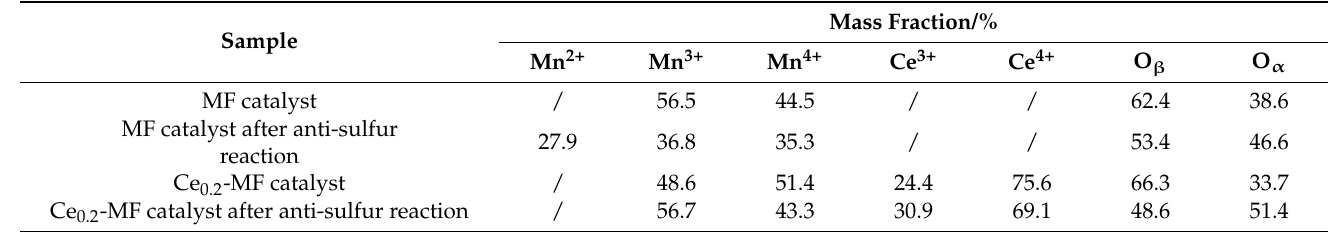
Table 2. XPS analysis results of MF and Ce 0.2 -MF catalyst before and after the anti-sulfur